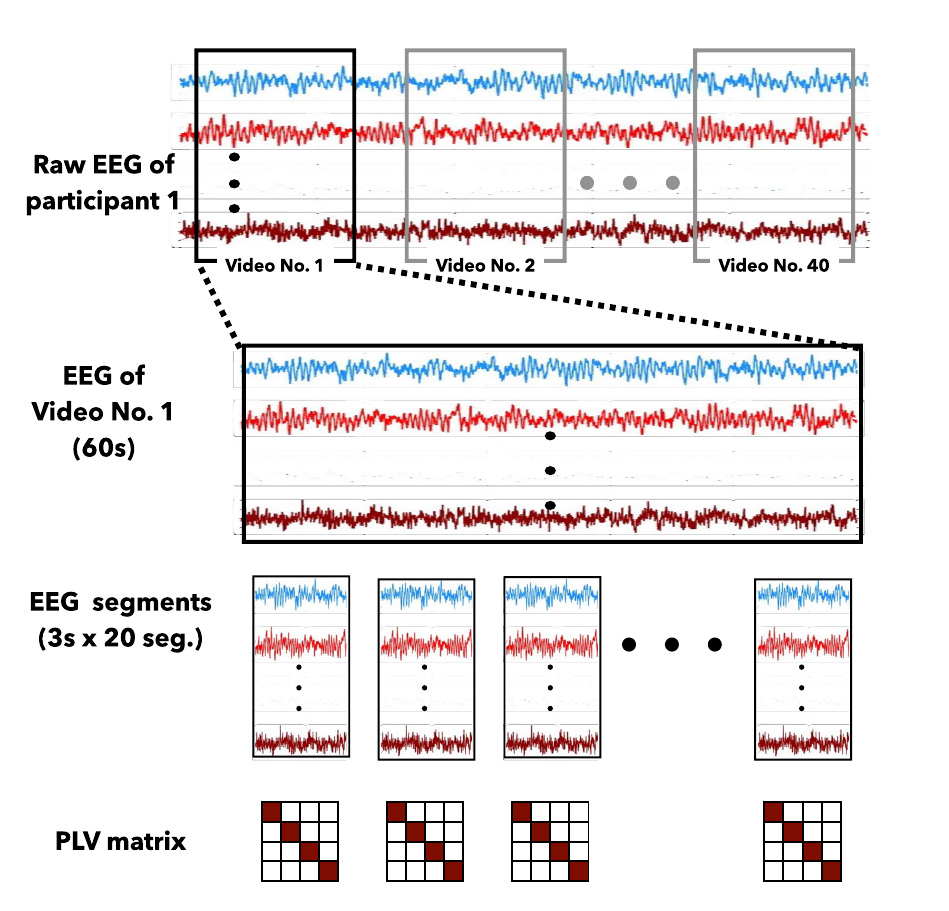
Figure 8. The example of EEG